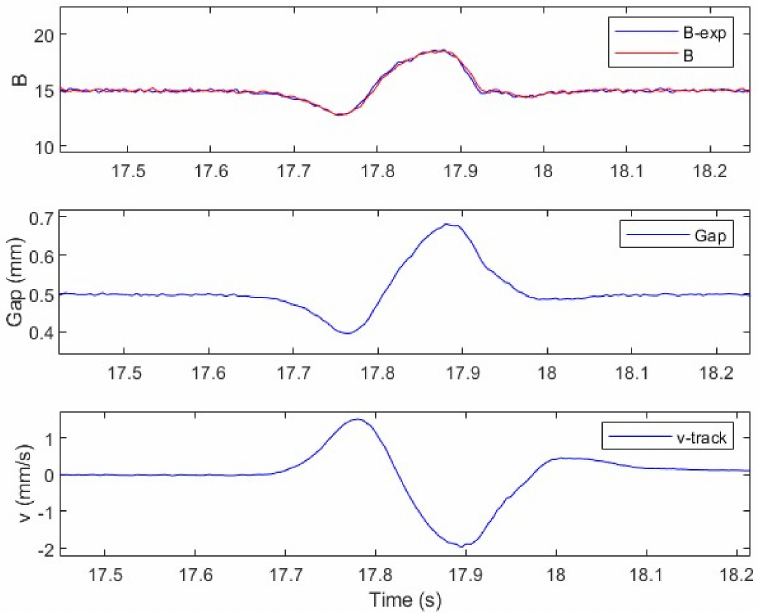
Figure 17. The suspension gap, vertical track displacement and vertical track velocity during the weight impact